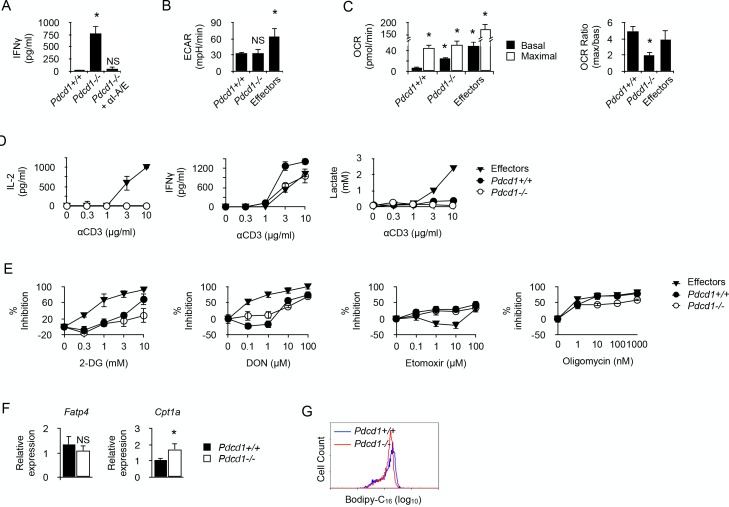
PD-1 is not required for the induction and maintenance of the metabolic profile developed by chronic CD4+ T cells.(A) IFNγ production in cultures of whole spleen cells isolated from male Rag2-/- Il2rg-/- B6 recipents adoptively transferred with anti-male Pdcd1+/+ or Pdcd1-/- Rag2-/- Marilyn T cells for 21 days. Anti-I-A/I-E antibodies were added as indicated. Data (mean ± SEM of five replicated cultures) are representative of three independent experiments. * indicates p=0.0079 (compared to Pdcd1+/+) by the Mann-Whitney test. NS indicates non-significant. (B) Basal ECAR of chronic Pdcd1+/+ or Pdcd1-/- CD4+ T cells and effector CD4+ T cells. Data (mean ± SEM of five replicated cultures) are representative of two independent experiments. * indicates p=0.0079 and NS indicates non-significant by the Mann-Whitney test. (C) Basal and maximal OCR of chronic Pdcd1+/+ or Pdcd1-/- CD4+ T cells and effector CD4+ T cells. (left panel). Maximal/basal OCR ratios (right panel). Data (mean ± SEM of five replicated cultures) are representative of two independent experiments. * indicates p=0.0079 by the Mann-Whitney test. (D) Chronic Pdcd1+/+ or Pdcd1-/- CD4 +T cells or effector CD4+ T cells were stimulated with anti-CD3/CD28 antibodies. After 48 hr, culture supernatants were harvested and lactate, IL-2 and IFNγ concentrations were determined as described in Material and methods. Data (mean ± SEM from five replicated cultures) are representative of three independent experiments. (E) Chronic Pdcd1+/+ or Pdcd1-/- CD4+ T cells or effector CD4+ T cells were stimulated with anti-CD3/CD28 antibodies in the presence of 2-DG, DON, Etomoxir or oligomycin. After 48 hr, culture supernatants were harvested and IFNγ concentrations were determined by ELISA. Percent inhibition was calculated as described in Materials and methods. Data (mean ± SEM) were calculated from five replicated cultures and are representative of three independent experiments. (F) Ex vivo relative expression of FATP4 and CPT1a mRNA in Pdcd1+/+ or Pdcd1-/- chronic T cells. Data (mean ± SEM) were calculated from five replicated cultures and are representative of three independent experiments. * indicates p=0.0079. (G) Bodipy-C16 uptake by in Pdcd1+/+ or Pdcd1-/- chronic T cells. Data are representative of two independent experiments.